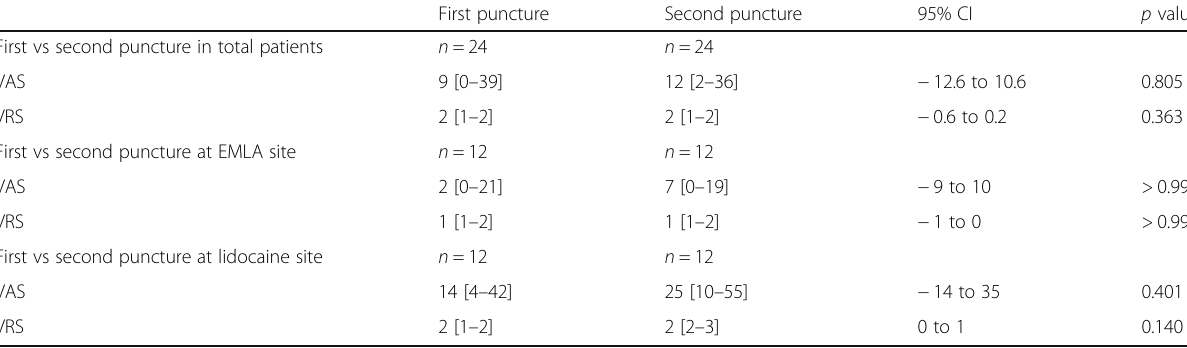
Table 3 Comparison of first and second puncture pain intensities First puncture Second puncture 95% CI p